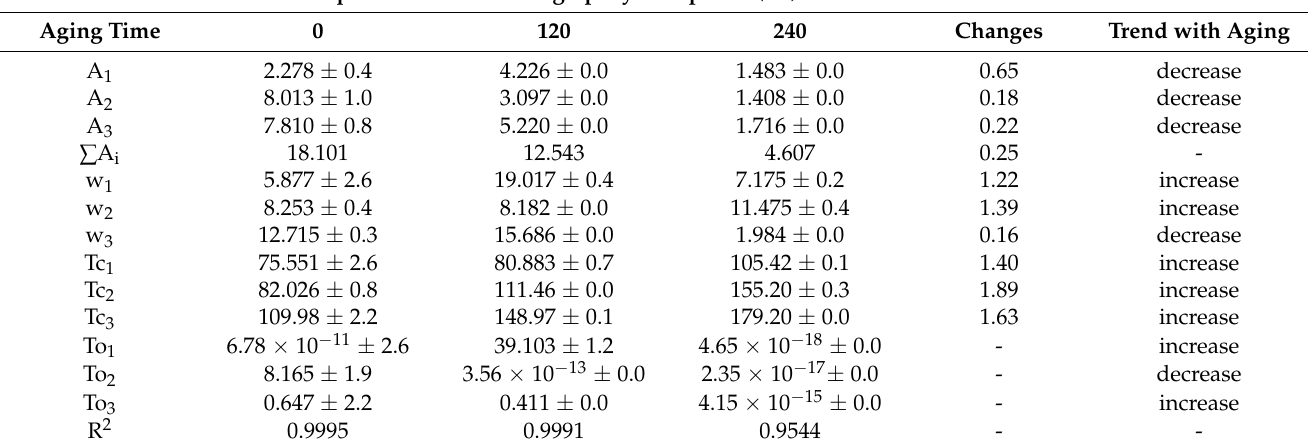
Table 5. EMG fit parameters of the loss factor curves for fique fabric-reinforced epoxy composite as a function of aging at high temperature. The column named ‘change’ gives the ratio of values between the aged state at 170 ◦ C, 240 h, and the unaged